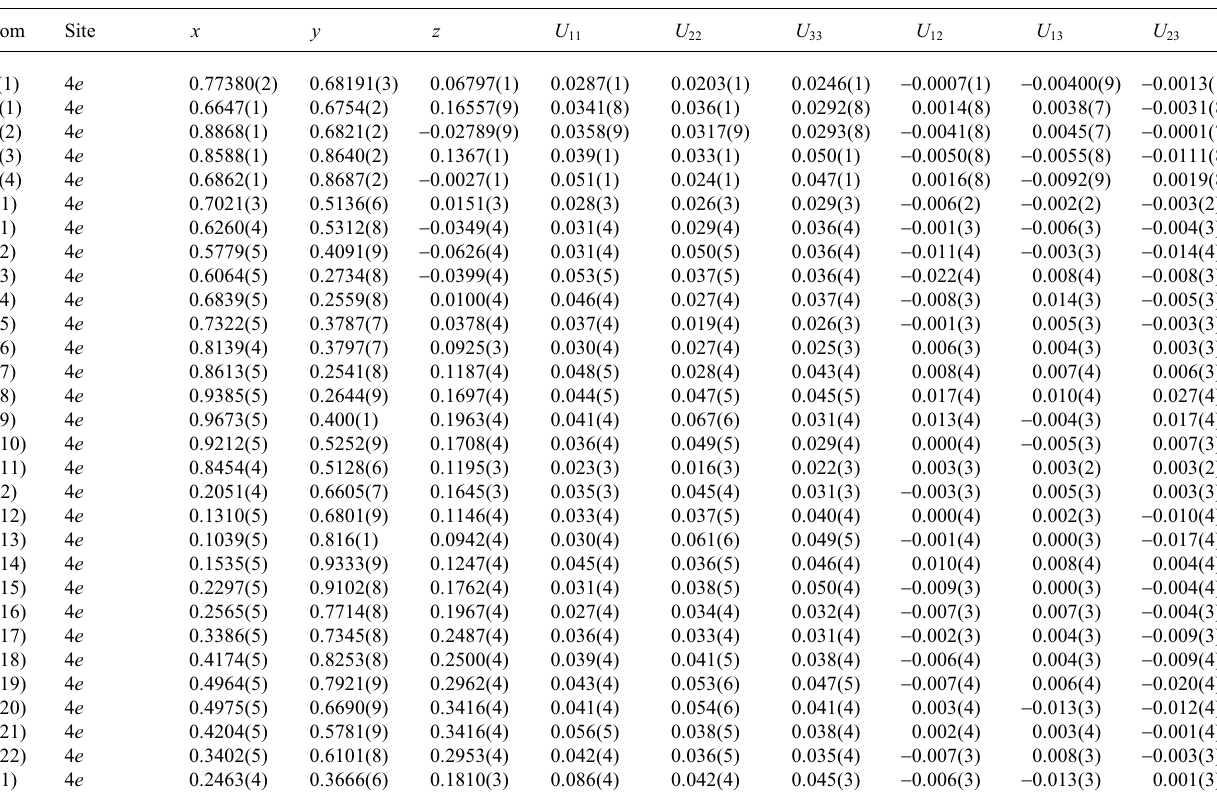
Table 3. Atomic coordinates and displacement parameters (in Å 2 ).